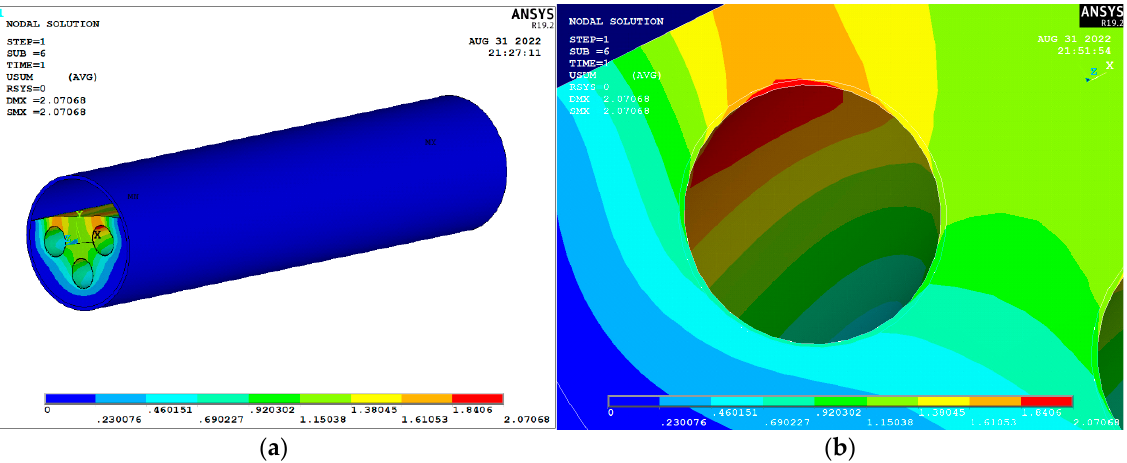
Figure 14. Deformation cloud chart under operating pressure: ( a ) Natural gas transmission tunnel; ( b ) Gas pipeline.